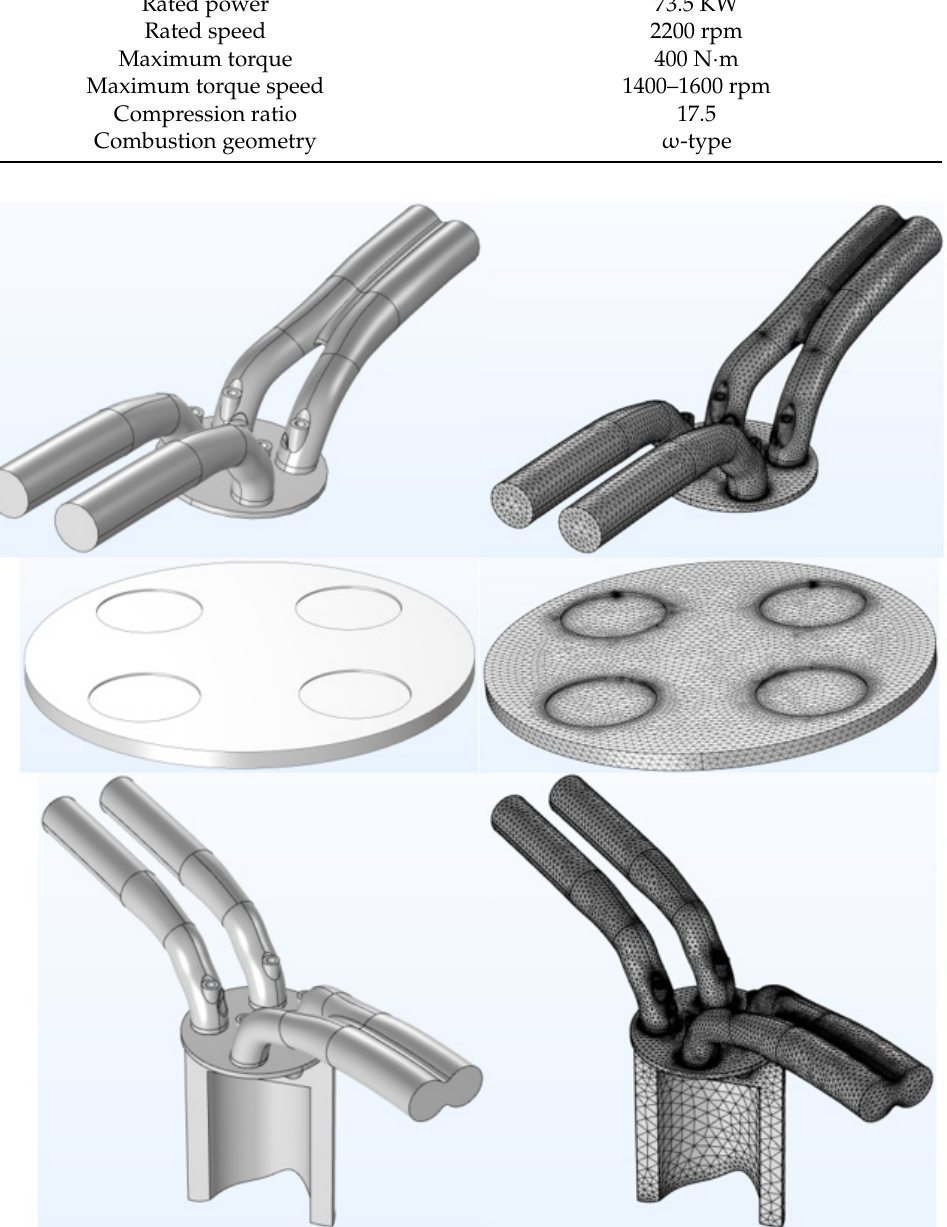
Figure 1. Engine geometry model and grid structure. Table 1. Main technical parameters of diesel engine.